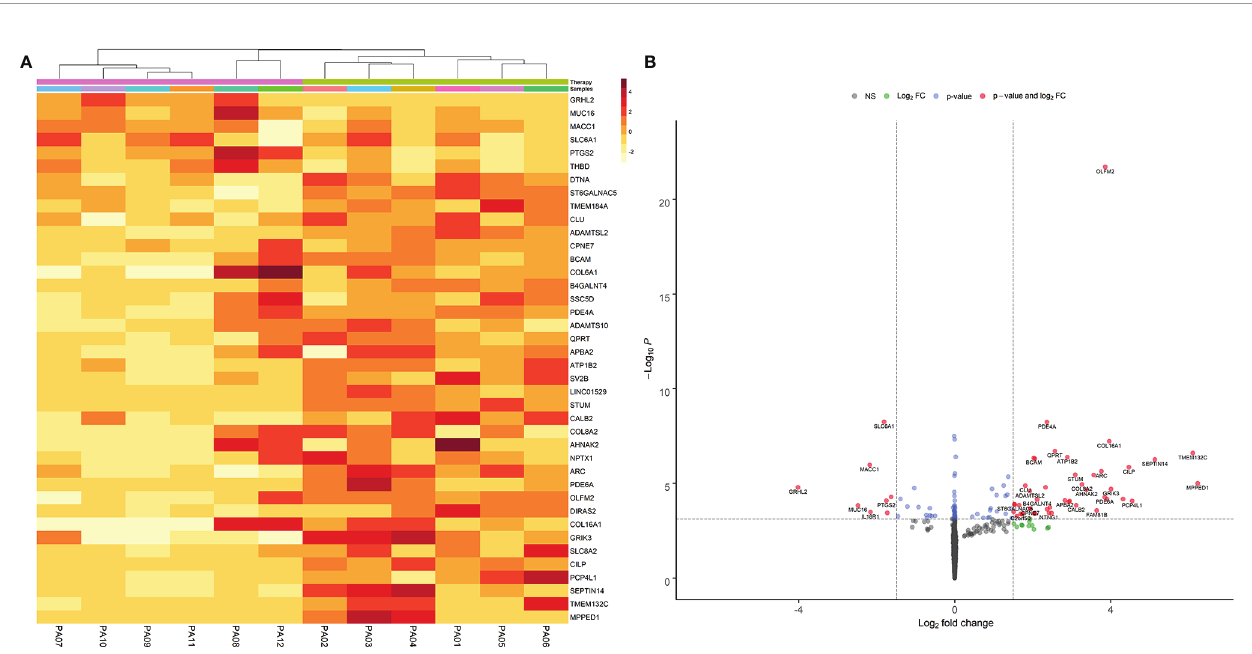
FIGURE 1 | Heatmap (A) of the statistically signi fi cant differentially expressed genes. Heatmap intensities were obtained by fi ltering apeglm transformed log fold change values with the following thresholds: abs. lfc >1.5 and padj <0.05. The color scale represents the approximate difference in each individual sample from the average, vst normalized read counts for that gene. Data is clustered both by genes and samples using the kmeans algorithm included in the pheatmap package. Volcano plot (B) of differential expression results with apeglm transformed log fold change values. Dashed vertical lines represent absolute log fold change threshold of 1.5 and horizontal dashed line represents p values threshold of 1.31e-4 or FDR ~0.05. Red dots represent signi fi cantly DEGs (FDR < 0.05 and absolute L2FC >